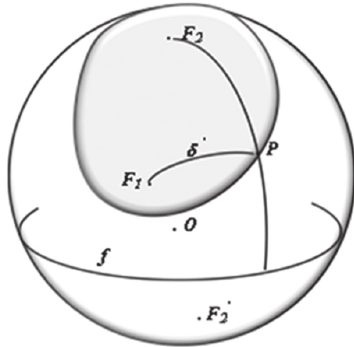
Fig. 3. The spherical conic “3 in 1” (parabola, ellipse,